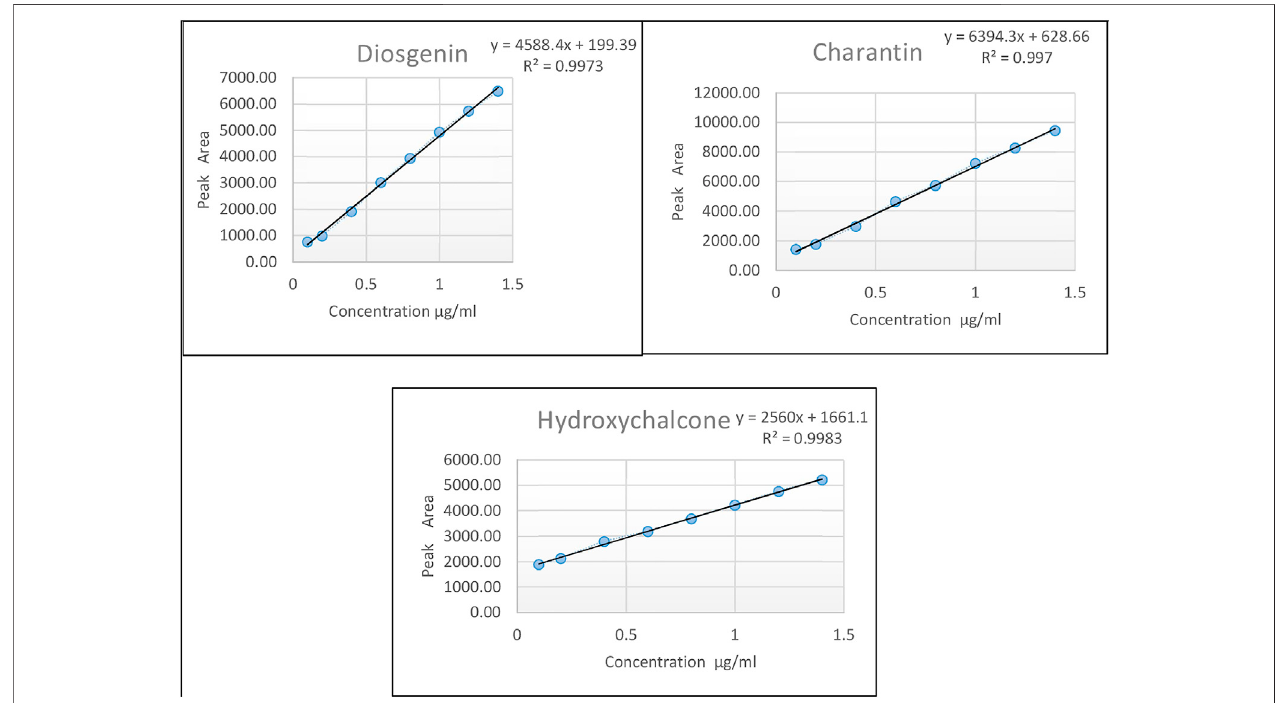
FIGURE 2 | Calibration curves of the marker compounds viz., diosgenin, charantin, and hydroxychalcone, respectively.